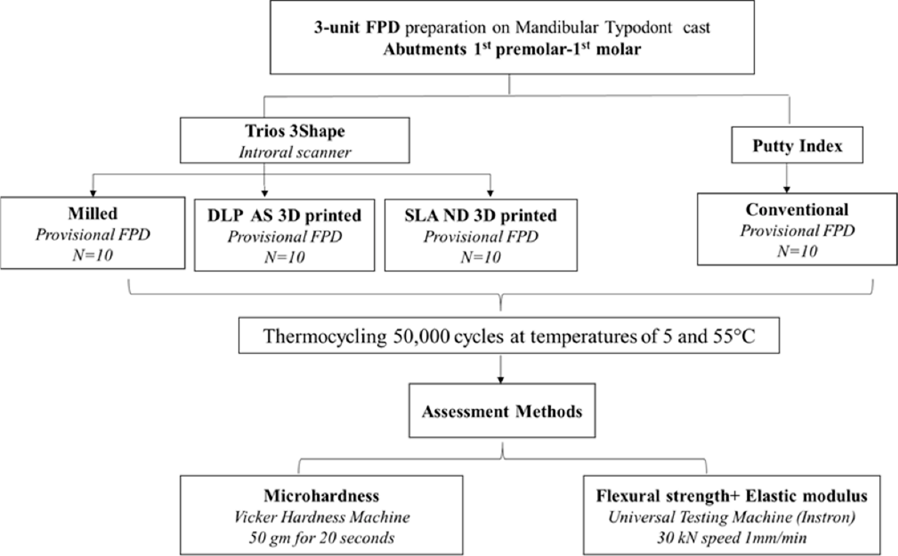
Figure 1. Flow chart of the study design.